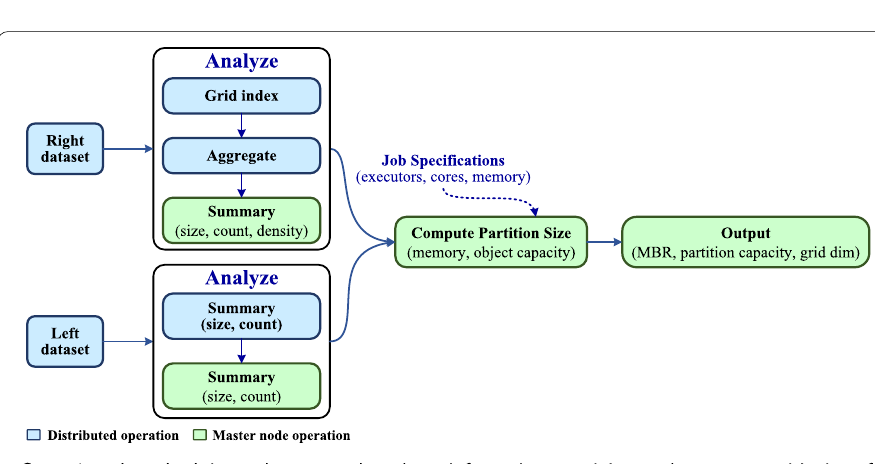
Minimum bounding region ( right dataset only): The MBR of the right (referred to as